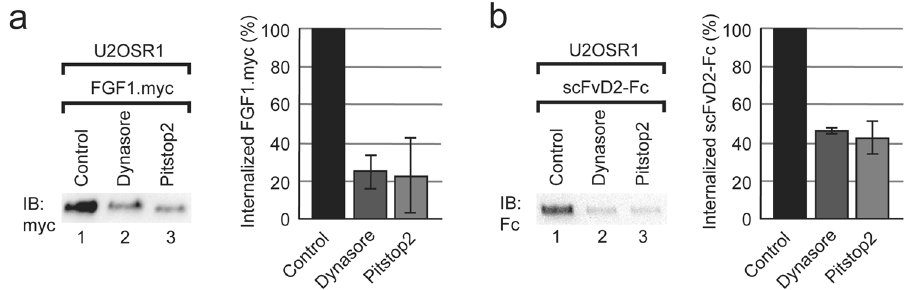
Figure 5. Internalization of FGF1 and scFvD2-Fc occurs via clathrin mediated endocytosis. Internalization of FGF1.myc ( a ) and scFvD2-Fc ( b ) into U2OSR1 cells was studied in the presence of inhibitors of dynamin (Dynasore; 80 µ M) and clathrin (Pitstop2; 30 µ M). Densitometric quantification of FGF1.myc and scFvD2-Fc internalization was performed with ImageJ from 3 independent experiments. Fraction of internalized FGF1. myc and scFvD2-Fc after treatment with inhibitors is represented as a percentage of untreated control. Error bars represent standard deviation. Cropped blots were displayed, full size blots are included in Supplementary